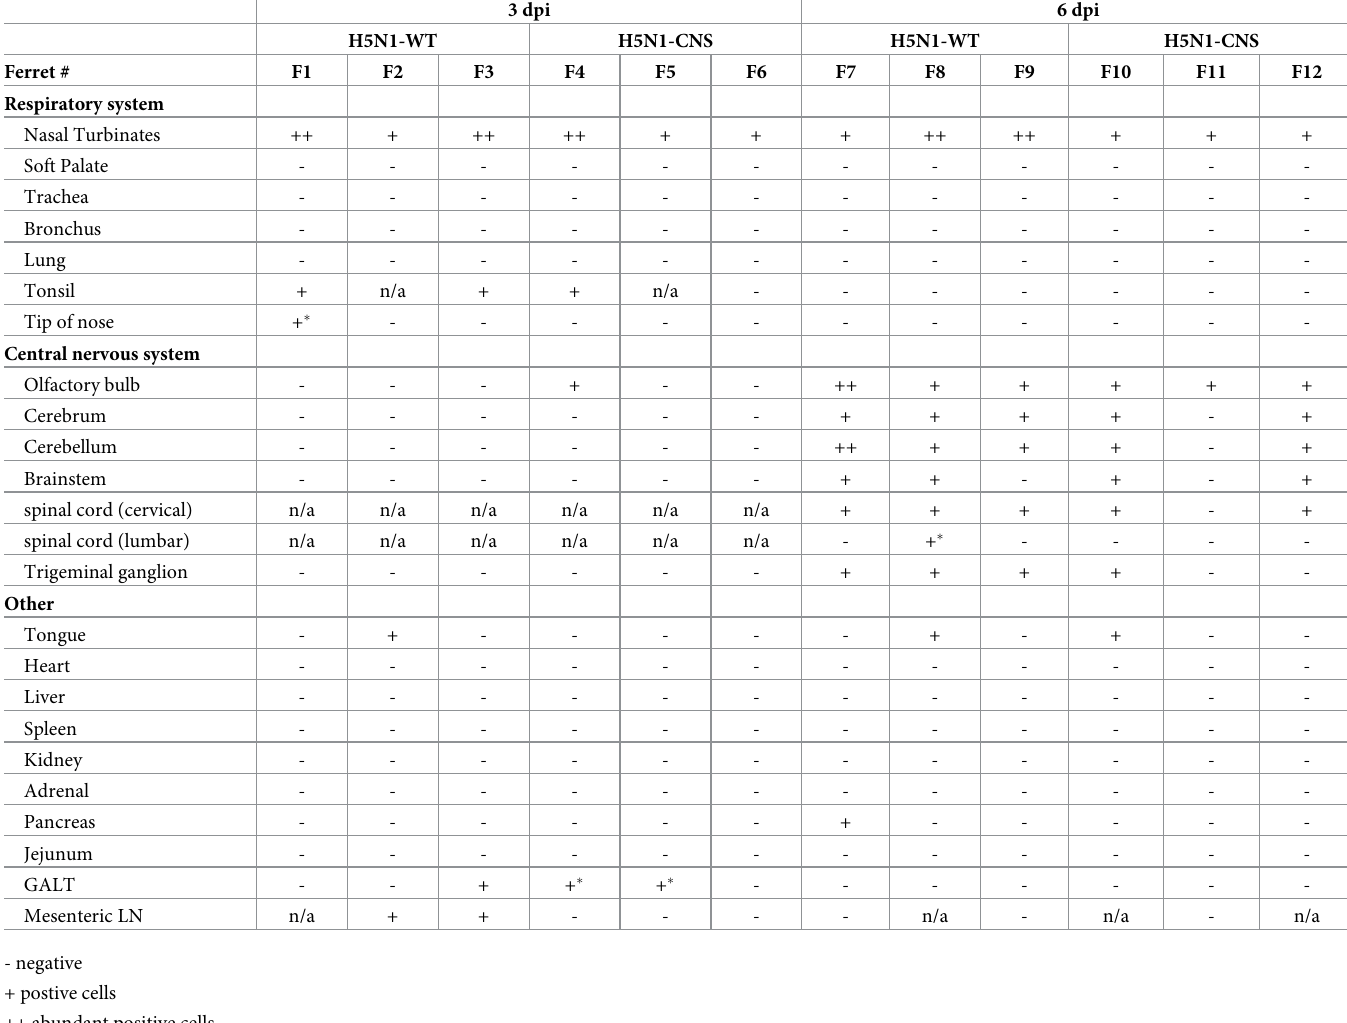
Table 3. Virus Antigen Detection in the respiratory tract, central nervous system, and other